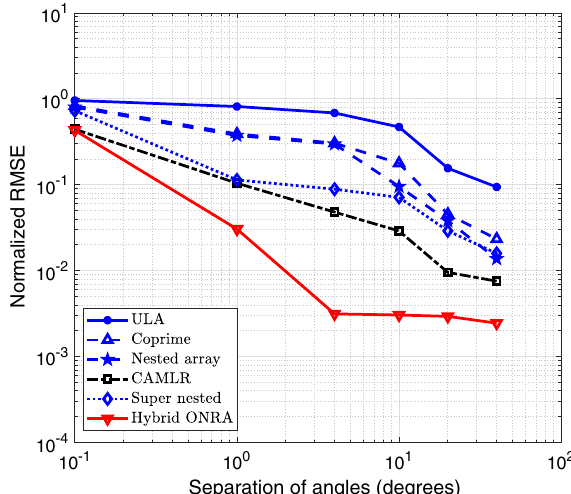
Fig. 6 RMSE of the CU-RIS channel versus the angular separation of the multipath (transmit power dBm)